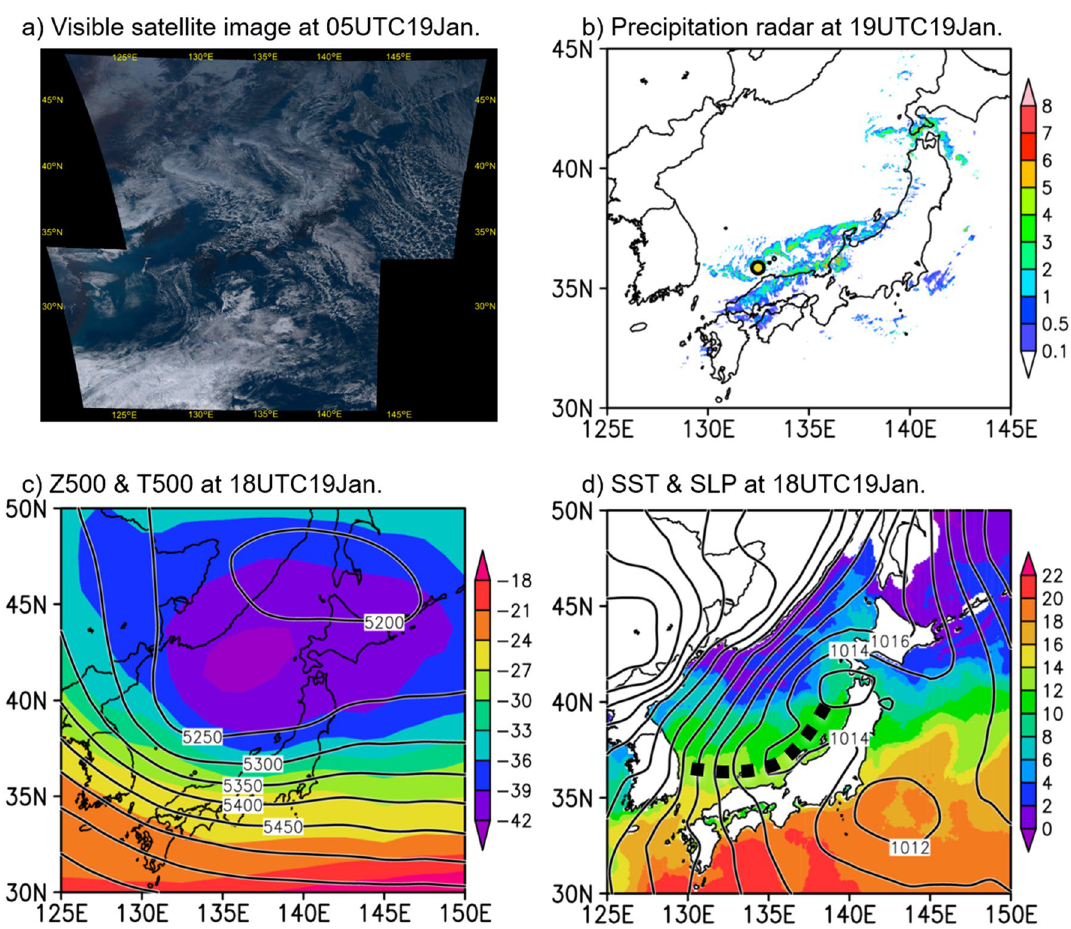
Figure 5. Visible satellite image, precipitation radar, surface and upper air atmospheric fields, and sea surface temperature field in the period of the JPCZ observation. ( a ) A Himawari satellite visible image at 05UTC 19 January, which corresponds to 14:00 local time. ( b ) Composite map of precipitation radar at 19 UTC 19 January, when the training ship crossed the centre of the JPCZ. A heavy circle indicates the ship location at 19 UTC 19 January. ( c ) Contours show 500 hPa geopotential height. Shadings show temperature at the level of 500 hPa at 18UTC 19 January. ( d ) Contours show sea level pressure at 18UTC 19 January, and the shadings shows sea surface temperature by HIM SST on 19 January. A dashed line indicates that a trough from a cyclone over the Tsugaru Strait elongated southwestward along the Japan Sea